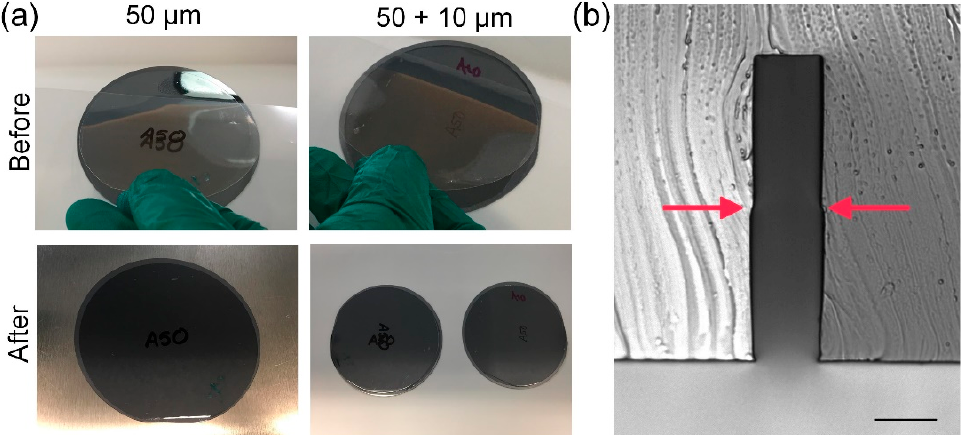
Figure 6. Images before and after lamination of double layered films. ( a ) First layer lamination using 50 µ m ADEX film on a clean silicon wafer. After completion, top protective film is peeled off and a second layer of 10 µ m thick ADEX film is placed directly on top; and ( b ) cross-sectional cut of PDMS cast on the double-laminated ADEX master. Arrows point to the joint between the layers of two 50 µm films. The scale bar is 25 µm.